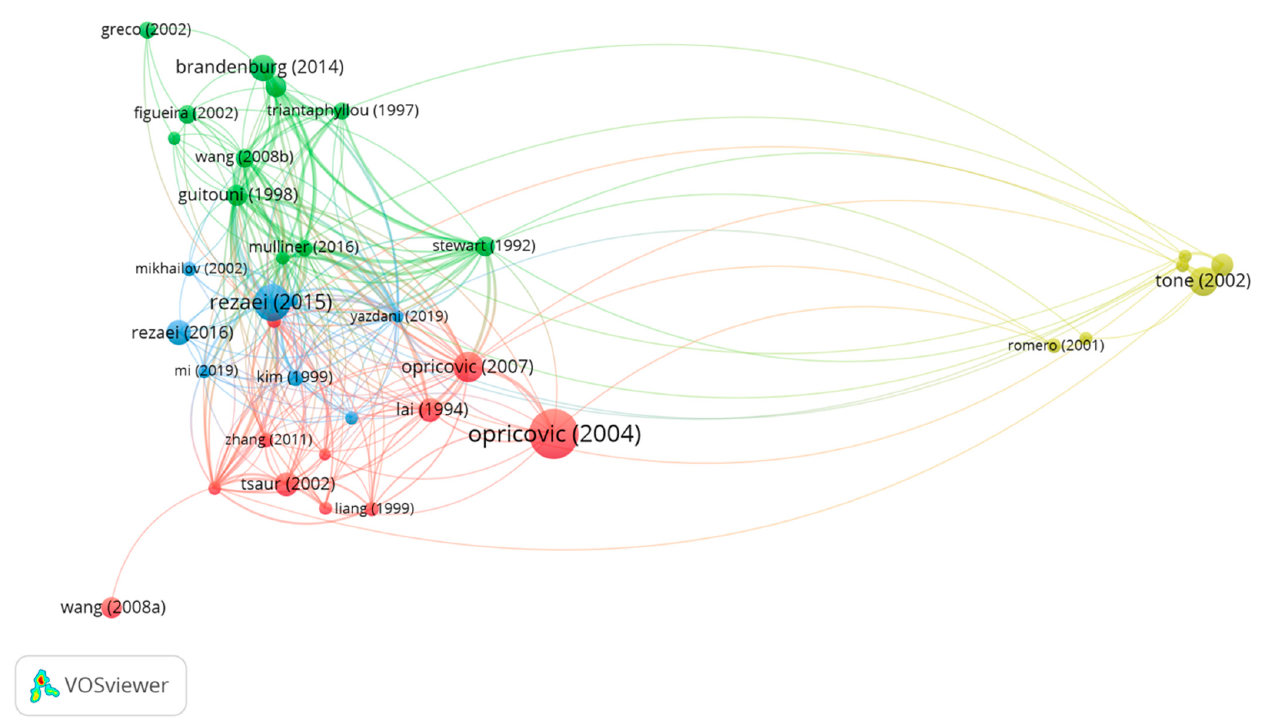
Figure 6. Coupling of articles with at least 150